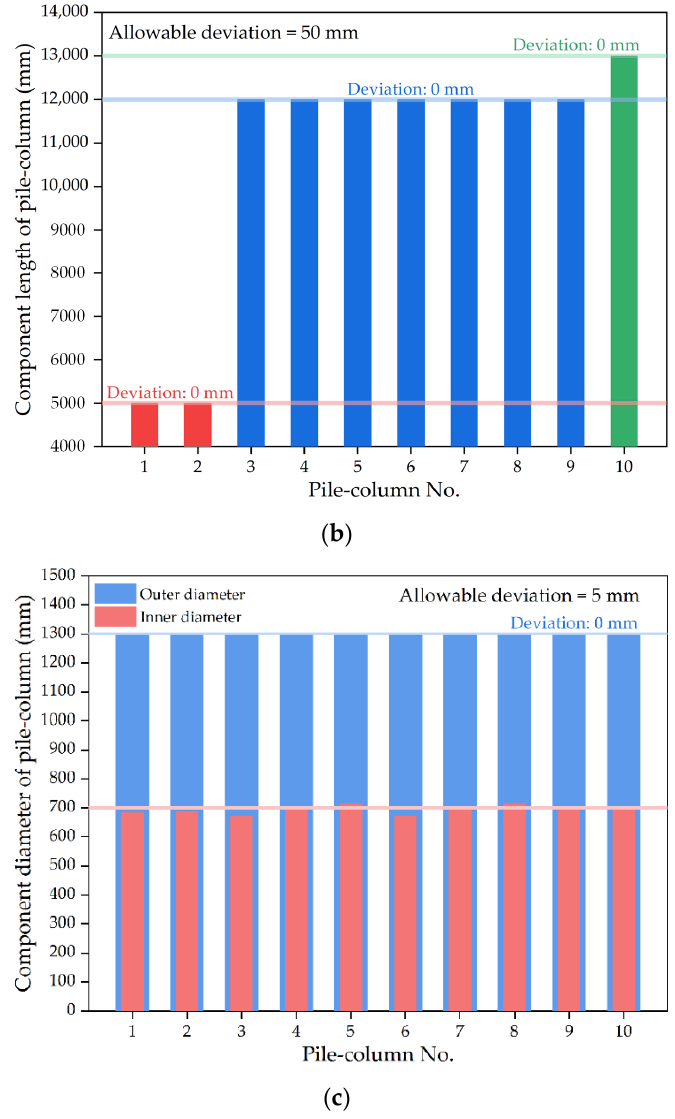
Figure 5. The component size monitoring for 10 prefabricated pile ‐ column specimens: ( a ) The component size monitoring test of a prefabricated pile ‐ column using Leica Nova series MS60 total station; ( b ) Pile length monitoring results and ( c ) Outer and inner diameter monitoring results.